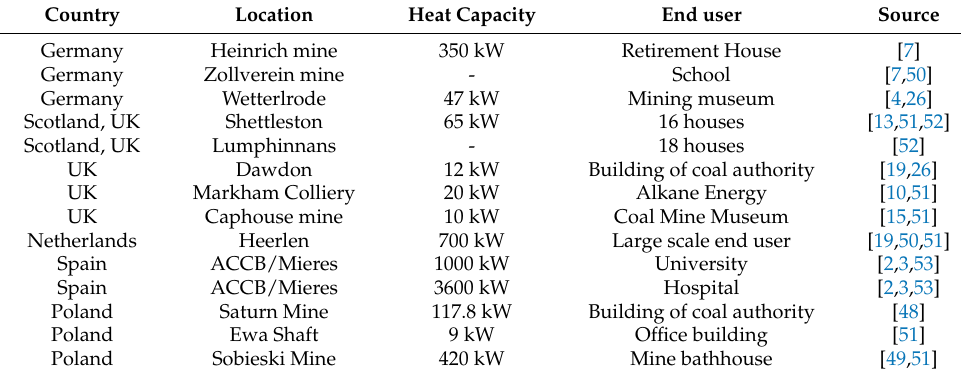
Table 7. Coal mine geothermal systems project in Europe.